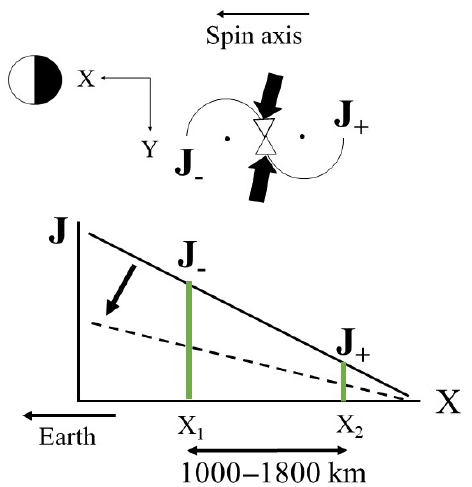
Figure 5. A schematic illustration of particle measurement in the x – y plane of GSE coordinates; x is earthward, and y is duskward in the ecliptic plane. For the time interval of a multiple-Pi2 event when the satellite was at 22:00MLT, duskward flux represented by ( J − ) came from the earthward sector and dawnward flux ( J + ) from the tailward sector. J − > J + because of the pressure gradient positive earthward. The spatial gradient is represented by a solid line chang- ing to a dotted line. Radial separation, x 1 − x 2 , is either 1000km or 1800km for 63–85keV ions or 125–210keV ions, respectively.